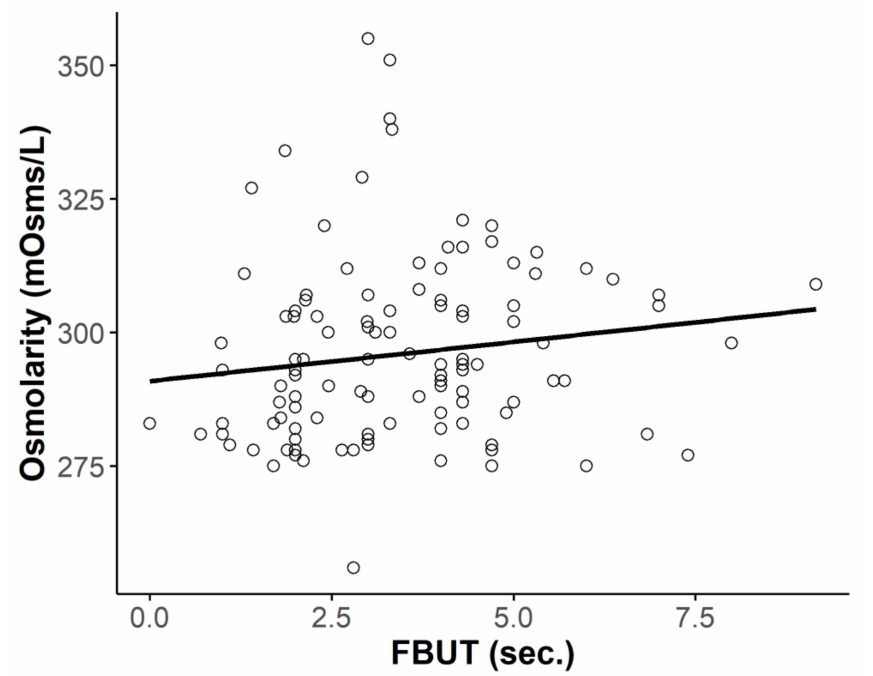
Figure 3. Relationship between total fluorescein tear breakup time (FBUT) and osmolarity. There was no correlation between FBUT and osmolarity ( r = 0.142, p = 0.118, Pearson’s correlation test). The osmolarity values in eyes with the aqueous-deficient, decreased wettability, and excessive evaporation TBUP were 295.89 ± 18.12, 289.38 ± 21.33, and 295.76 ± 12.22 mOsms / L, respectively ( p > 0.05, Tukey–Kramer test; Figure 4).